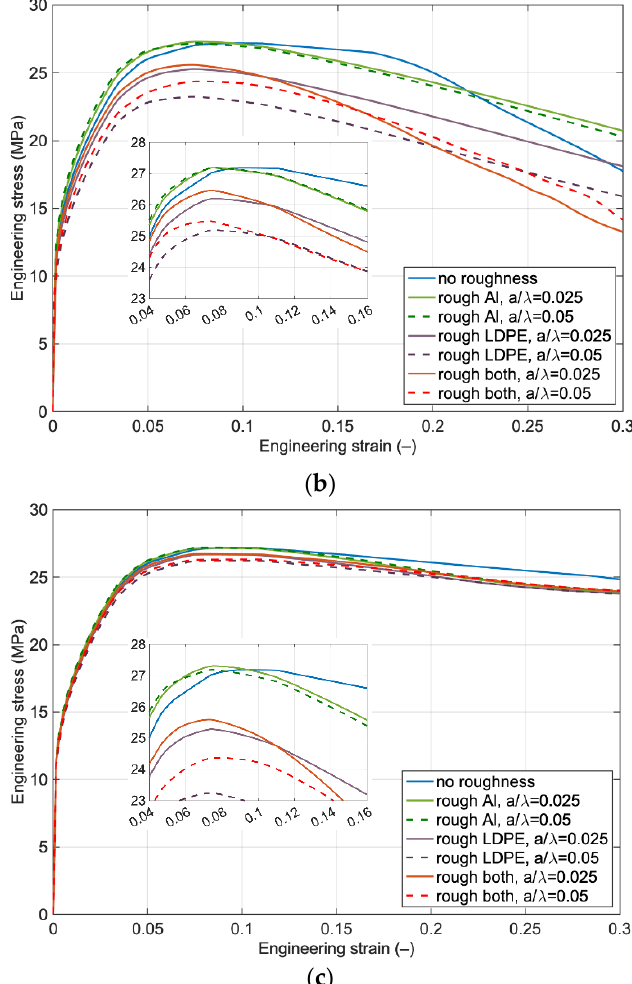
Figure 5. The effect of roughness on engineering stress versus engineering strain for the laminate with wavelength ( λ ) equal to ( a ) h/2, ( b ) h and ( c ) 2 h and different amplitudes.